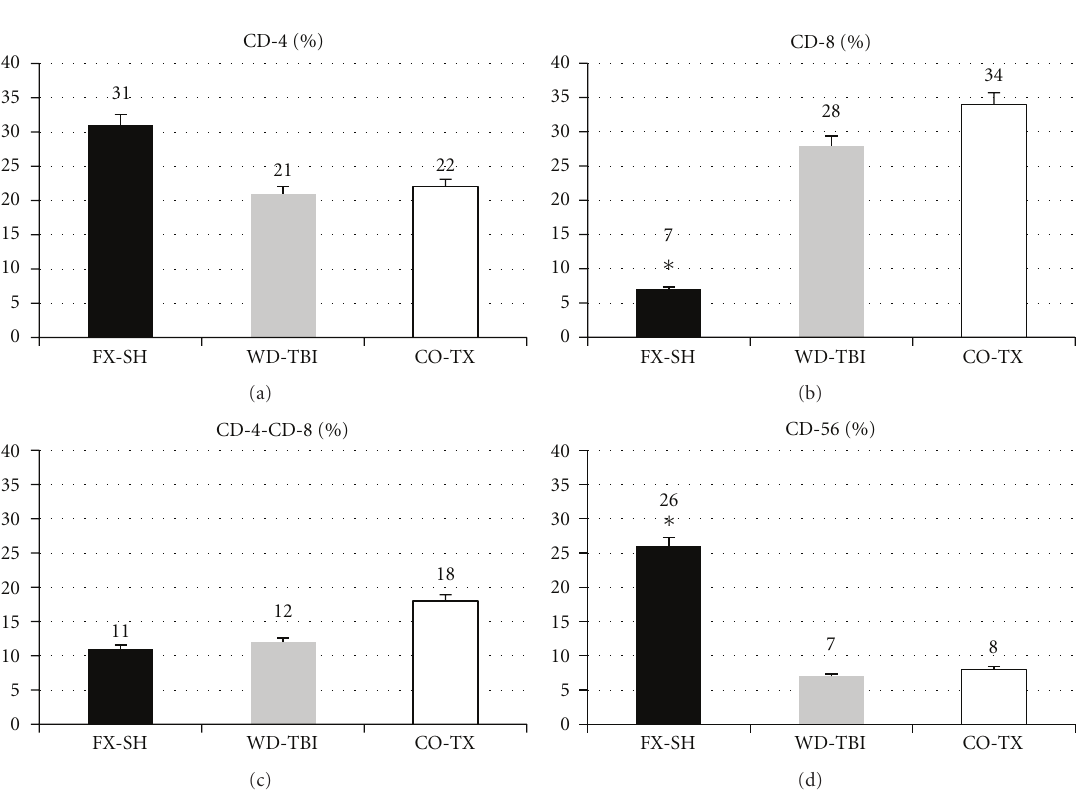
Figure 3: Lymphocyte subpopulations (%). FX-SH: femur fracture and shock; WD-TBI: weight drop traumatic brain injury; CO-TX: combined